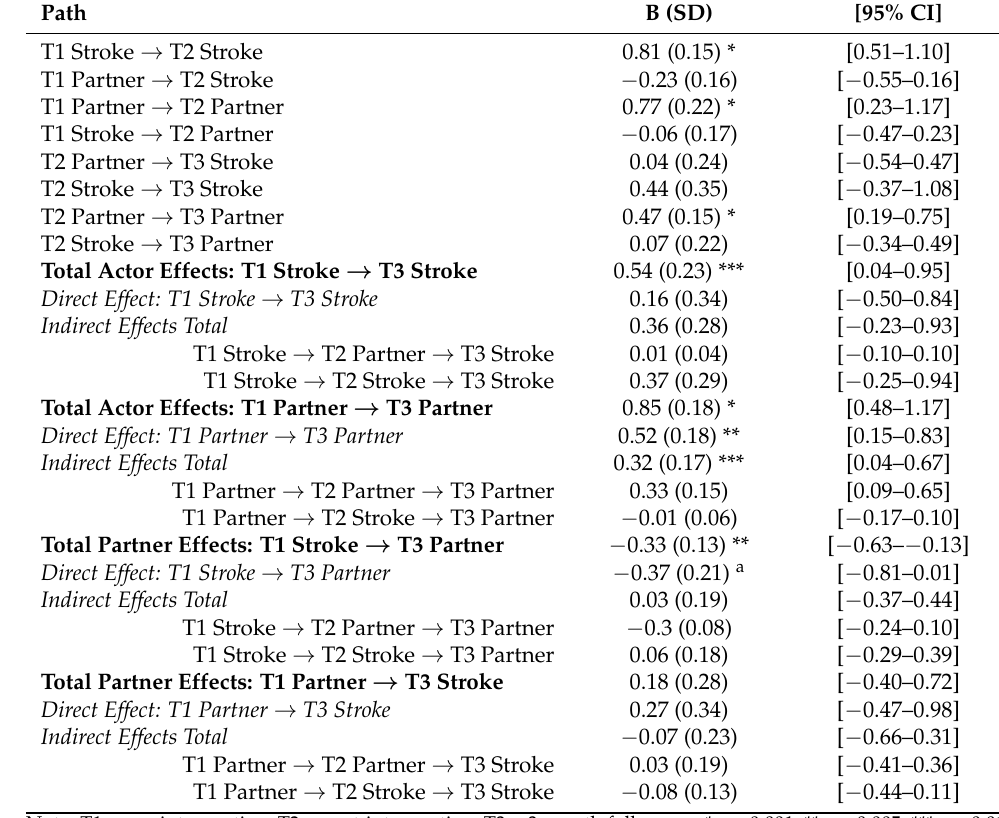
Table 4. Direct, specific indirect, and total effects for APIM